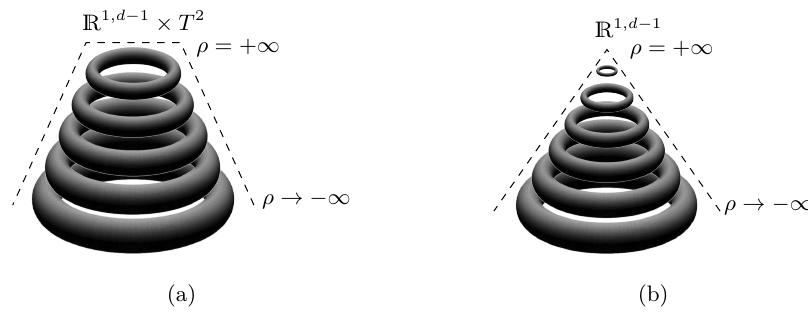
Figure 2 . Wedge holography picture for T 2 compactification. On the left the torus is of finite size at the conformal boundary of AdS (measured without the e 2 ρ factor in the metric). On the right it shrinks to zero size (again measured without the e 2 ρ factor)